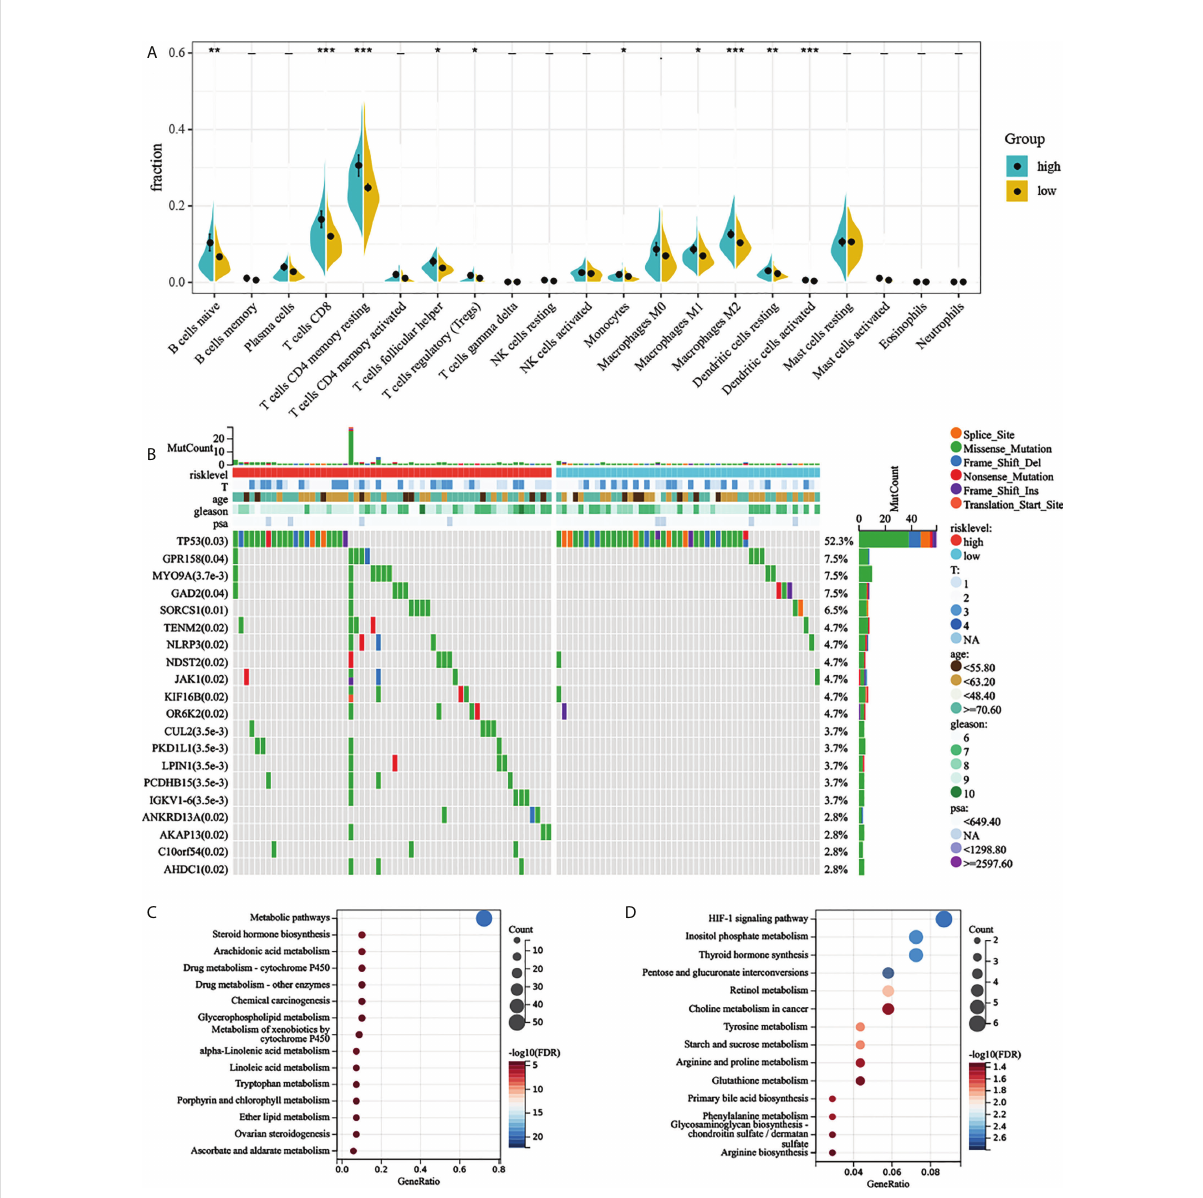
FIGURE 6 Comprehensive analyses of different risk groups. (A) Relative proportion of in fi ltrating immune cells in low- and high-AGRS prostate cancer patient of TCGA-PRAD cohort. (B) Top 20 most frequently mutated genes were illustrated in TCGA-PRAD. (C, D) Enrichment analysis of metabolic genes in different risk subgroups. “ * ,**, *** ” stands for statistically signi fi